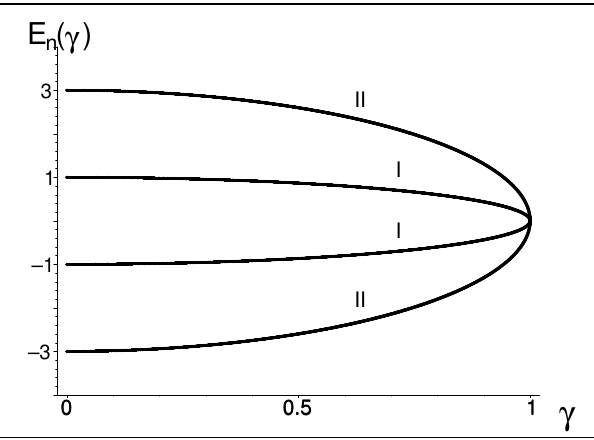
Figure 2. The BEC degeneracy (3) at N =